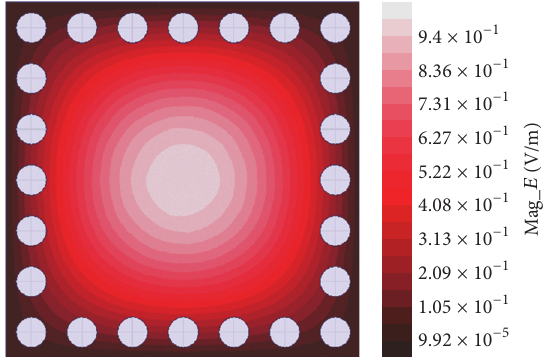
Figure 2: The field distribution at TE 101 resonant